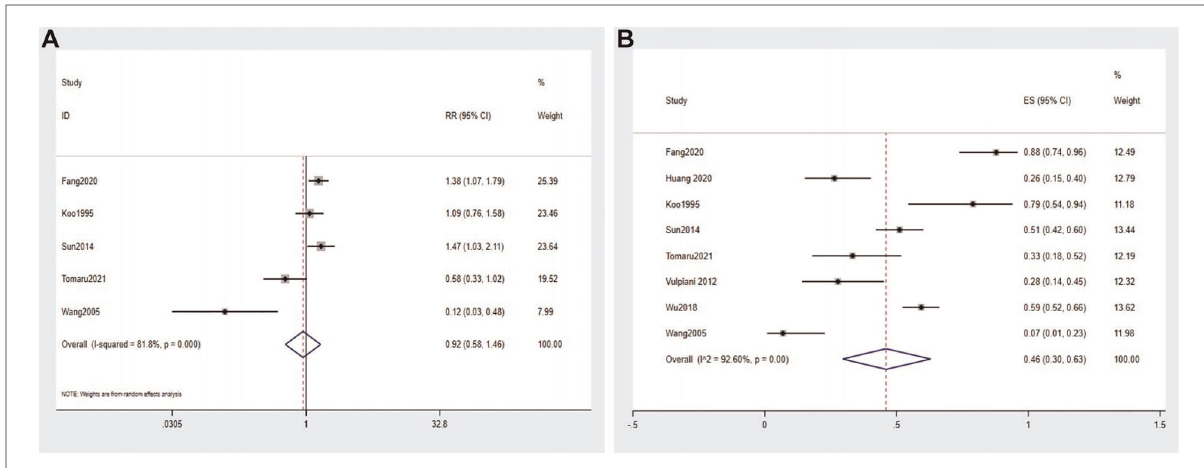
FIGURE 4 Forest plot of the collapse rate. ( A ) The forest plot of the random effects model for 1 RCT and 4 comparative studies; ( B ) the forest plot of the random effects model for a single-arm meta-analysis of 8